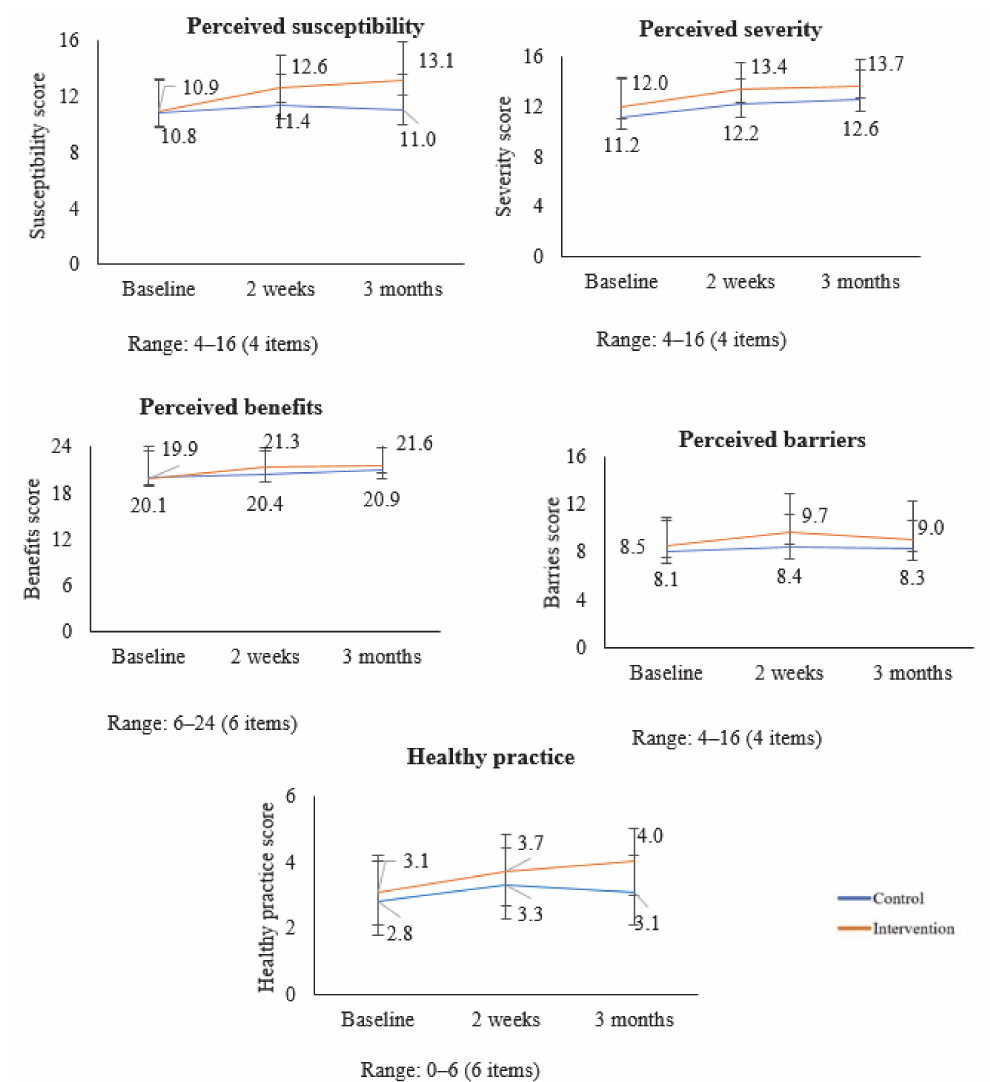
Figure 3. Changes in Total Health Belief Subscale Scores, and Healthy Practice of Knowledge-sharing Partners over